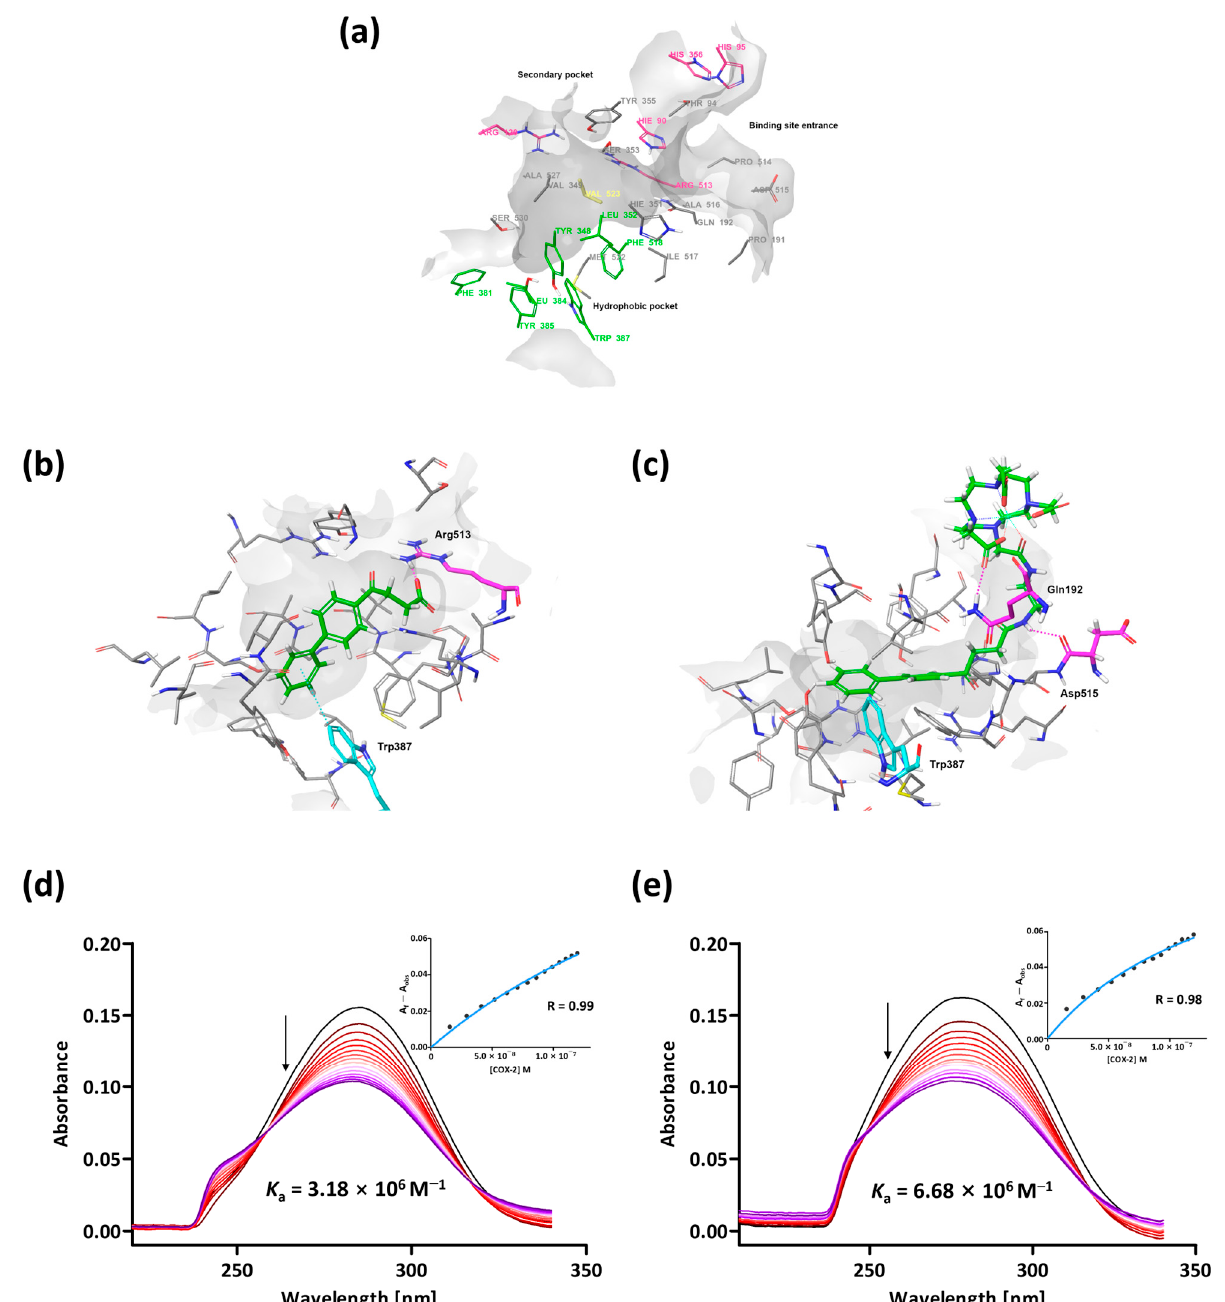
Figure 3. The binding sites and binding affinity of COX-2 for Gd-DO3A-fen and the NSAID. ( a ) The drug-binding site of COX-2 consists of the main hydrophobic and secondary pockets. ( b ) The docking results for fenbufen. This drug was bound to Arg 513, and Trp 387 deep in the hydrophobic pocket, with ionic and π – π stacking interactions. ( c ) The docking results for Gd-DO3A-fen. The binding conformation of Gd-DO3A-fen was associated with polar interactions with surface protein and π – π stacking interactions in the hydrophobic pocket. ( d ) COX-2-binding a ffi nity of fenbufen in UV–vis spectra. Samples were prepared in DMSO. COX-2 was dissolved in Tris-HCl bu ff er. ( e ) COX-2-binding a ffi nity of Gd-DO3A-fen in UV–vis spectra. Samples were prepared in Tris-HCl (1:9, pH 7.0) bu ff er. ( d , e ) The absorbance of fenbufen and Gd-DO3A-fen were decreased by the addition of COX-2 enzyme. The inset graphs represent the fi tt ing curve for the calculation of the binding constant ( K a ).